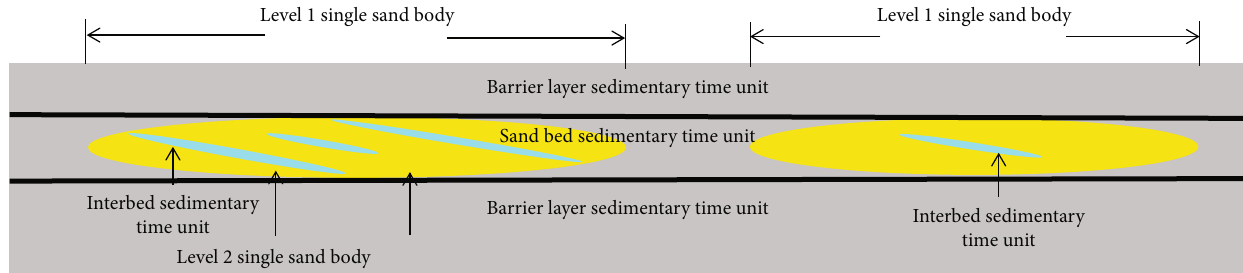
Figure 7: Conceptual model of single sand